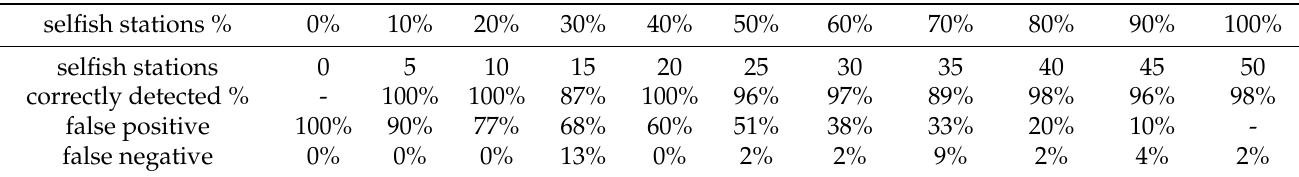
Table 2. Principal-agent detection method for 50 stations in UDP scenario.